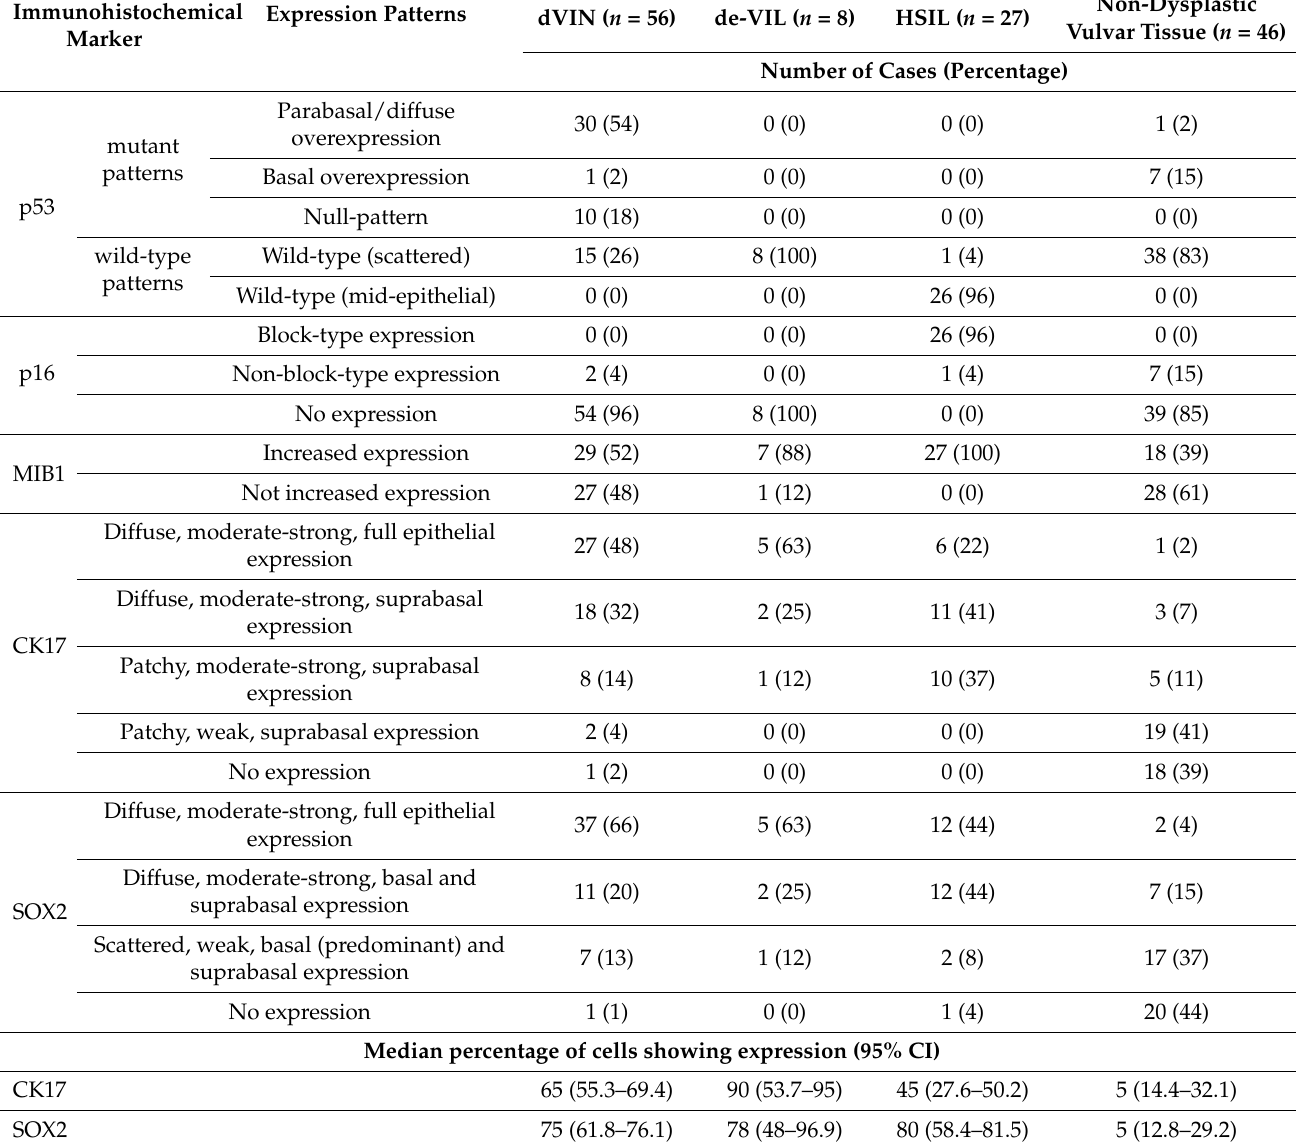
Table 2. Immunohistochemical expression of p53, p16, CK17, SOX2, and